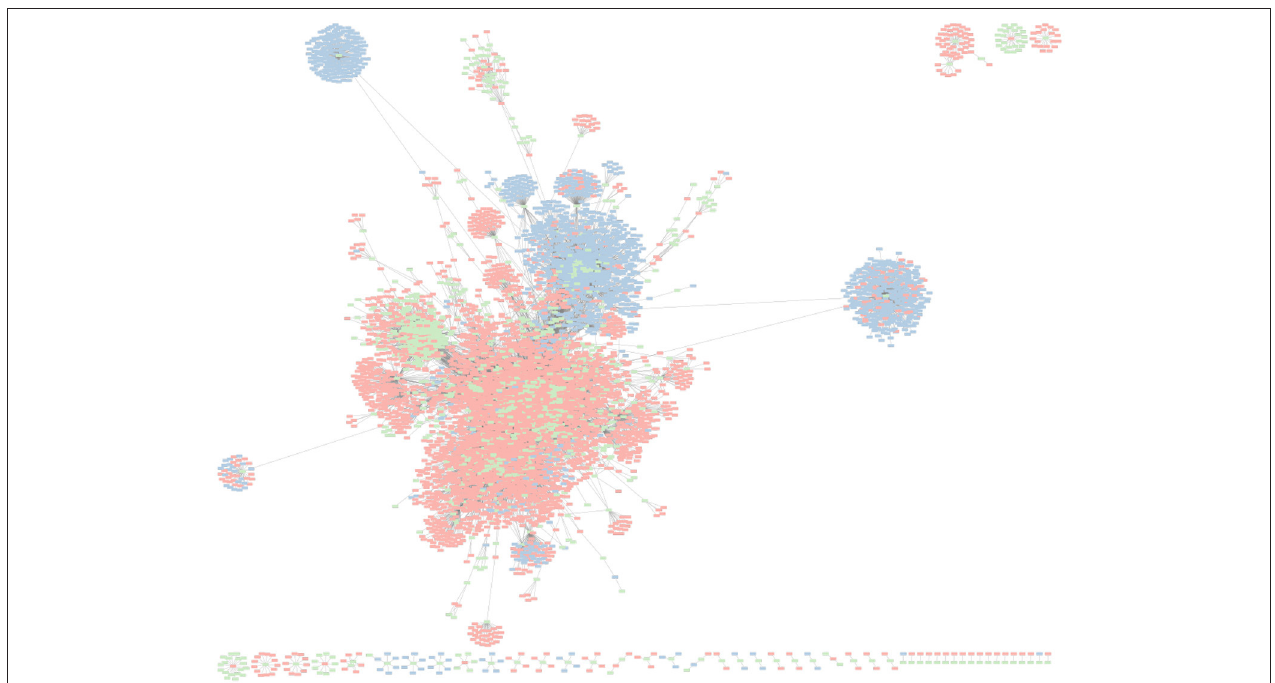
FIGURE 7 | Network graph representing K. pneumoniae associated CRISPR–Cas spacers and their corresponding putative MGE (e.g., phage, plasmids) targets. Green nodes represent unique CRISPR–Cas spacer sequences found in K. pneumonia reference genomes. Red nodes represent phage genomes. Blue nodes represent plasmid genomes. An edge between spacer and MGE nodes is depicted when a spacer has a corresponding protospacer in a given